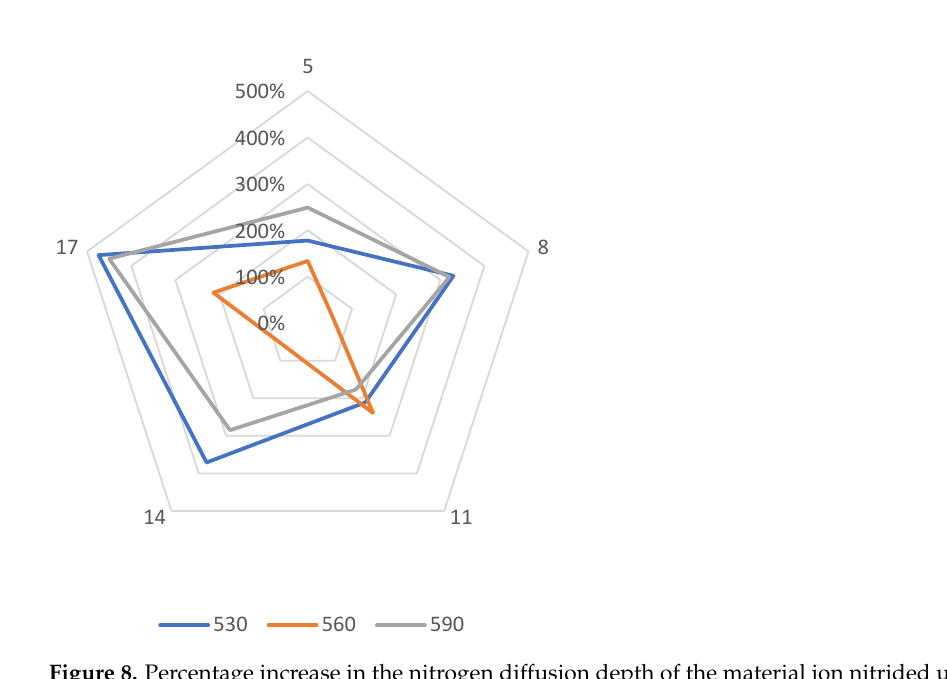
Figure 8. Percentage increase in the nitrogen diffusion depth of the material ion nitrided using the “active screen” method in relation to cathodic nitriding with different duration of the process (5 h, 8 h, 11 h, 14 h, 17 h).